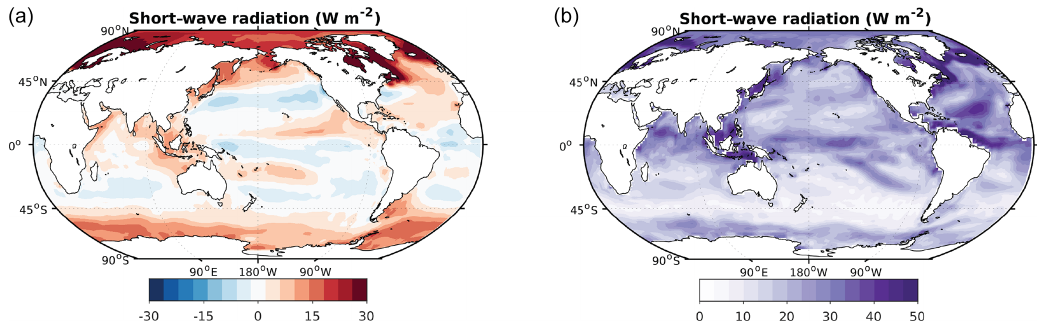
Figure 3. Annual mean downwelling short-wave radiation lgm–piControl anomaly (a) and model spread (b) (in Wm − 2 ).